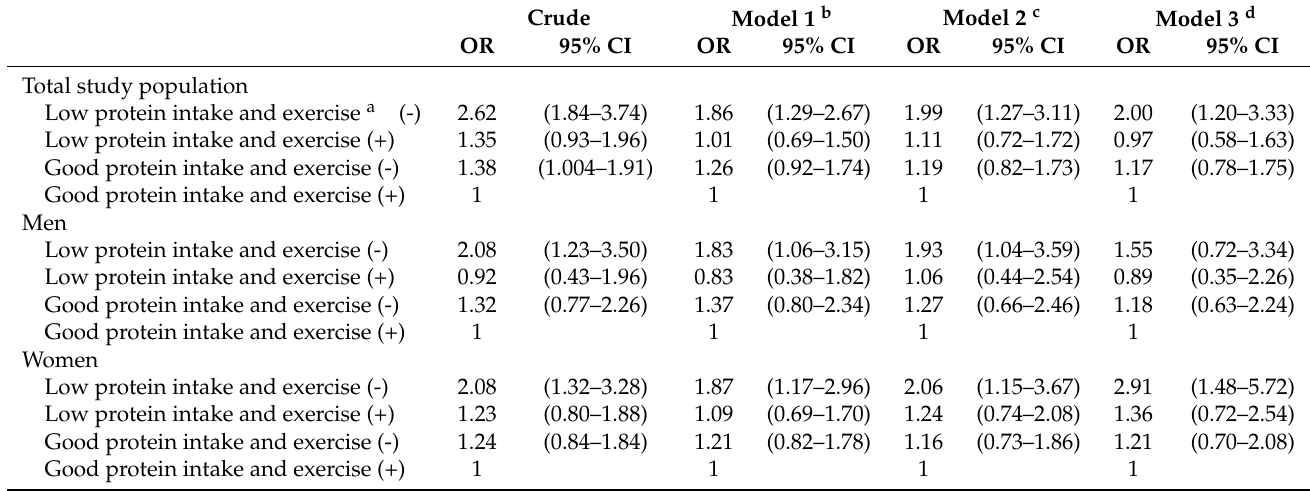
Table 5. Association between combined protein intake, regular exercise, and low back